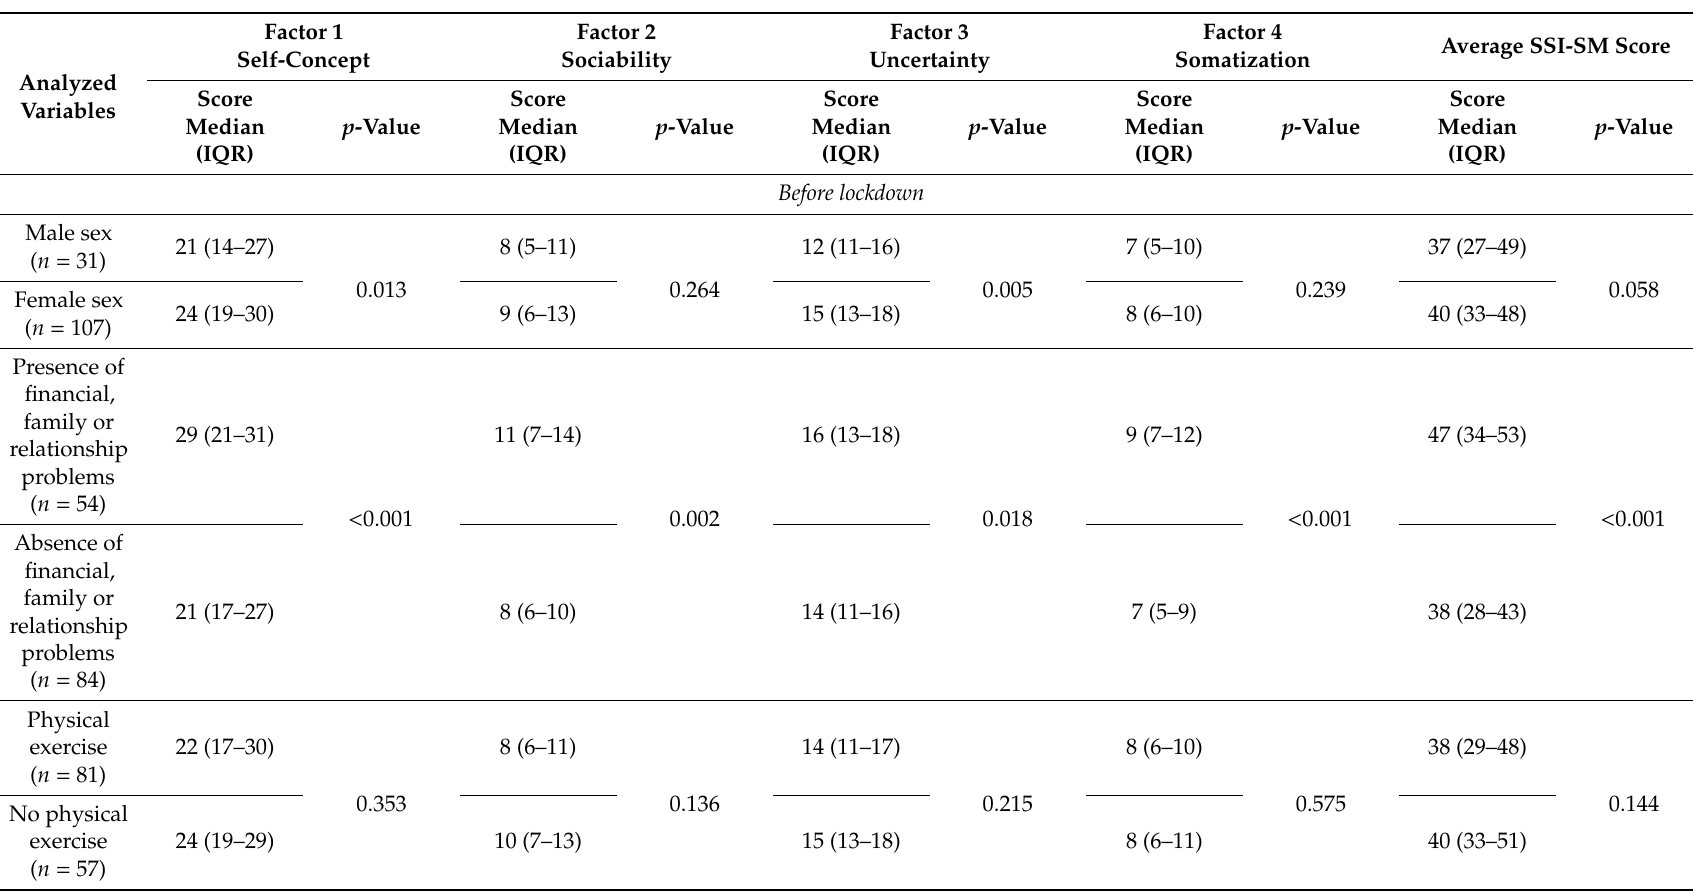
Table 3. Relationship between the Student Stress Inventory-Stress Manifestations (SSI-SM) score and sex, financial, family or emotional problems, and physical exercise, before lockdown, 10 days after lockdown, and 40 days after